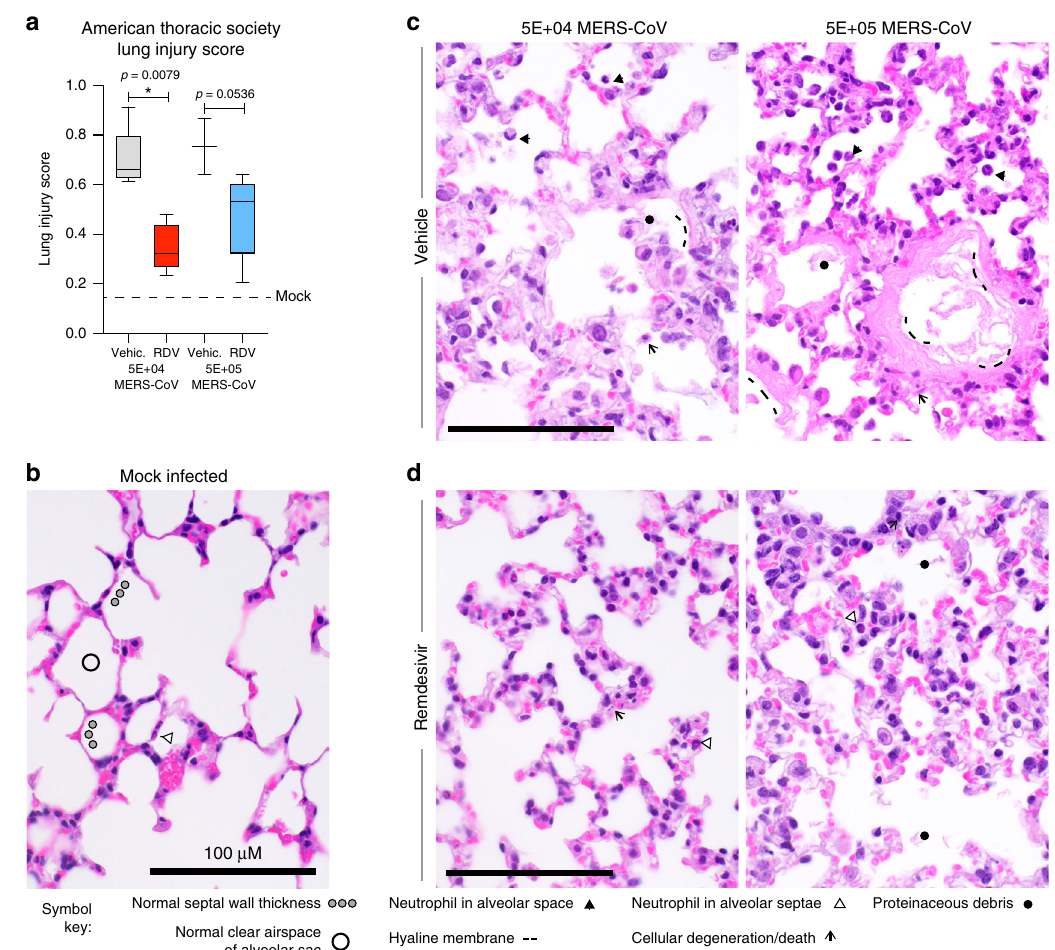
Fig. 3 Remdesivir prophylaxis reduces features of acute lung injury. The histological features of acute lung injury were blindly scored using the American Thoracic Society Lung Injury Scoring system creating an aggregate score for the following phenotypes: neutrophils in the alveolar and interstitial space, hyaline membranes, proteinaceous debris fi lling the air spaces, and alveolar septal thickening. Three randomly chosen high power (×60) fi elds of diseased lung were assessed per mouse. Representative images are shown for mock infected as well as those administered prophylactic vehicle or RDV and infected with either 5E + 04 or 5E + 05 pfu mouse adapted MERS-CoV. The numbers of mice scored per group: Vehicle 5E + 04 pfu MERS-CoV N = 5, Vehicle are indicated in the fi gure. All images were taken at the same magni fi cation. The black bar indicates 100 µ m scale. For the graph, the boxes encompass the 25th to 75th percentile, the line is at the median, while the whiskers represent the range. Statistical signi fi cance was determined by Mann – Whitney